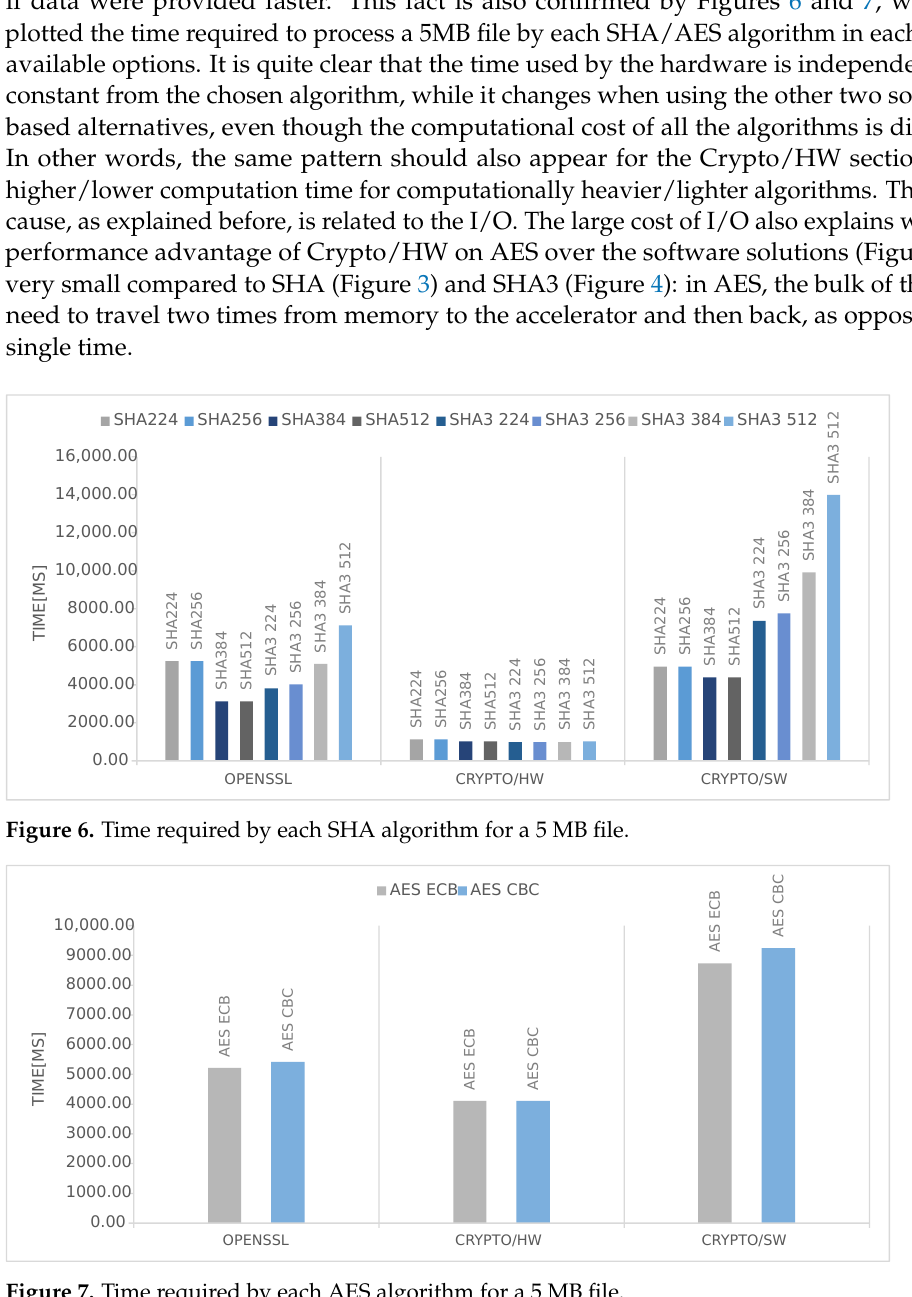
Figure 7. Time required by each AES algorithm for a 5 MB